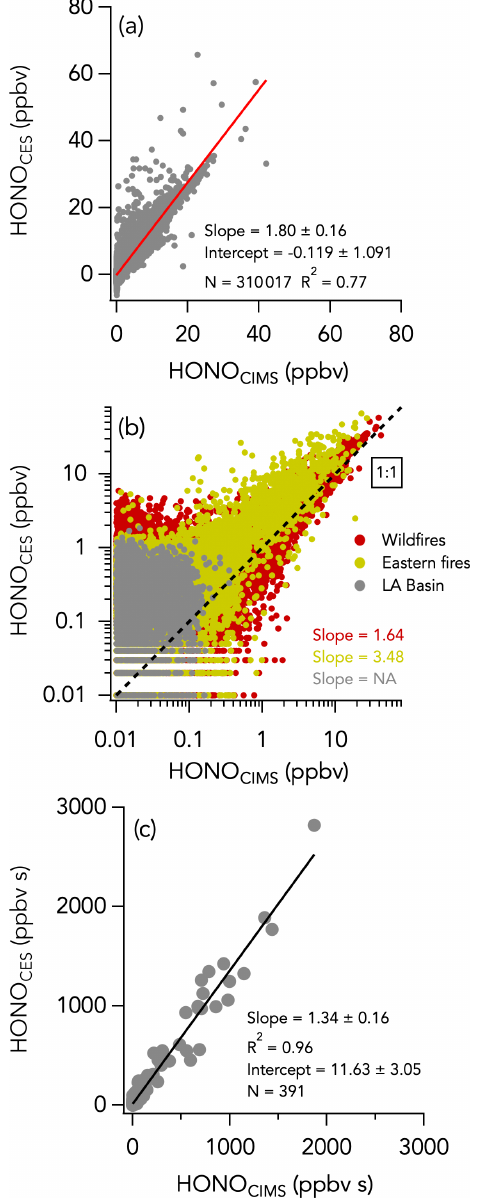
Figure 8. The same as Fig. 2 but comparing HONO measurements by CES and CIMS. No slope is given for the Los Angeles (LA) flights in panel (c) as most of the HONO signal at that time was be- low the instruments’ detection limits. Data from the entire campaign are presented in panels (a) and (b) .